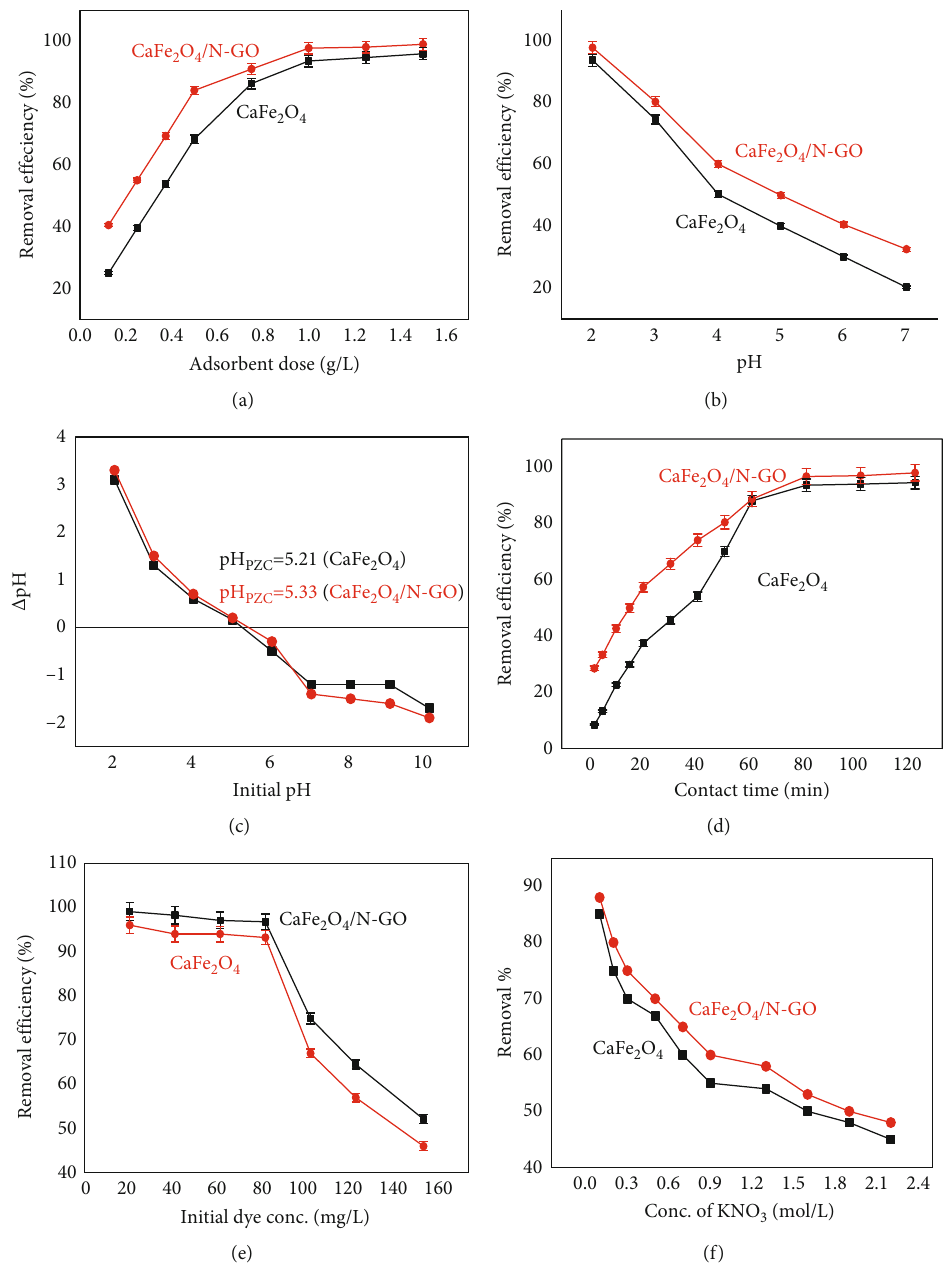
Figure 6: The e ff ect of adsorbent dose (a), e ff ect of pH (b), point of zero charge (c), e ff ect of contact time (d), e ff ect of initial dye concentration (e), and e ff ect of ionic strength (f) for the removal of RO12 dye over CaFe